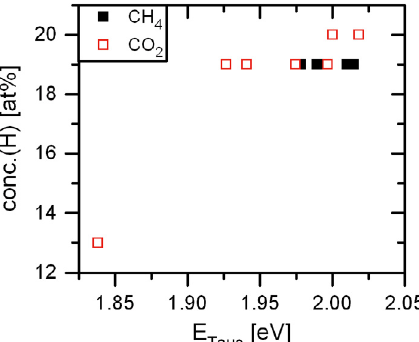
Fig. 7. Microstructure factor ms of amorphous silicon alloy single layers produced with CO 2 or CH 4 on c-Si wafers.